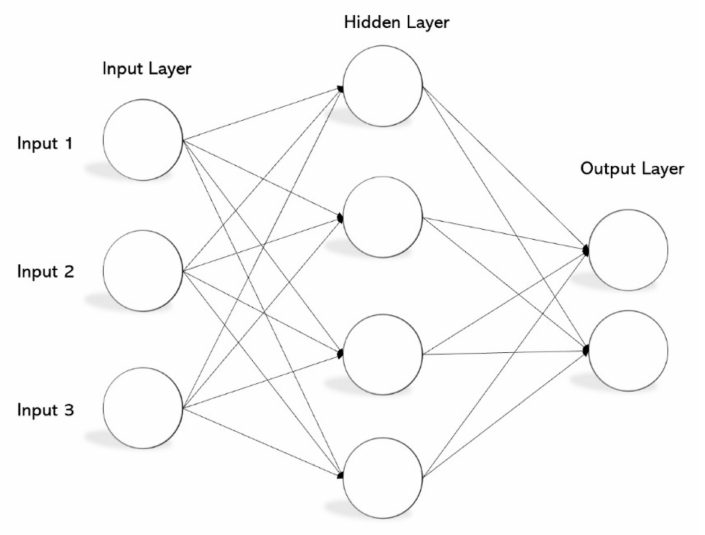
Figure 1. Neural network (MLP)